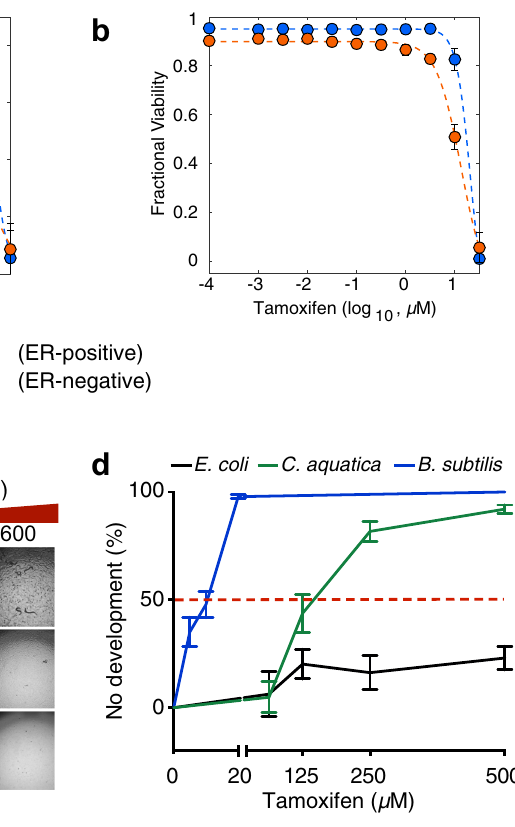
Fig. 1 | Tamoxifen kills ER-negative breast cancer cells and animals. a , b The growth rate index ( a ) and fractional viability ( b ) of ER-positive (T-47D) and ER- negative (MDA-MB-231) breast cancer cells plotted as a function of increasing concentrationsoftamoxifen.Datawererepresentedasmean±SDoffourtechnical replicates. Representative results of one out of three independent experiments. c Bright- fi eld images showing C. elegans supplemented with increasing doses of tamoxifen, fed E. coli , C. aquatica , and B. subtilis . Images were taken at 2x magni- fi cation after 48h exposure to tamoxifen. Scale bars: 1mm. Representative results